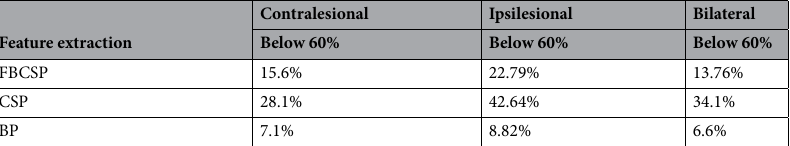
Table 2. Percentage of the patients with the average BCI accuracy (bilateral channels, contralesional, or ipsilesional) less than 60% using different BCI feature extraction methods.